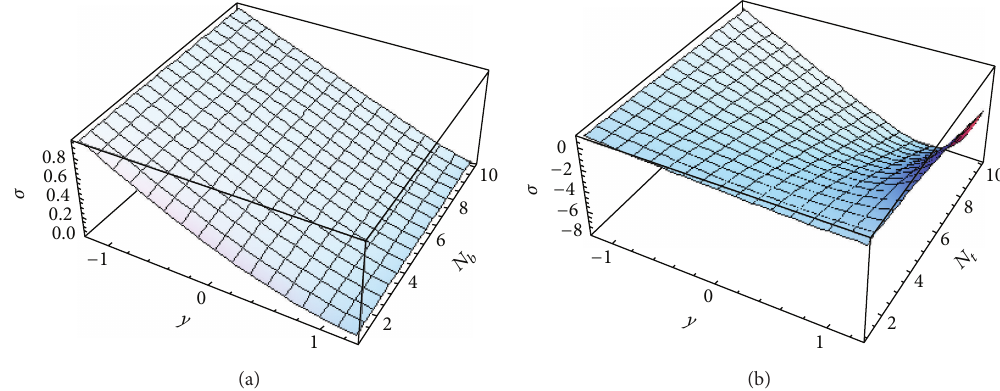
Figure 9: Variation of nanoparticle concentration at different values of (a) 𝑁 𝑏 for 𝑁 𝑡 = 0.8 and 𝑞 = 0.5 and (b) 𝑁 𝑡 for 𝑁 𝑏 = 0.8 and 𝑏 = 0.5 ; both cases when 𝑑 = 1 , 𝑎 = 0.5 , 𝜙 = 0.2 , 𝑥 = 1 , 𝛾 = 0.1 , and 𝛾 1 = 0.1